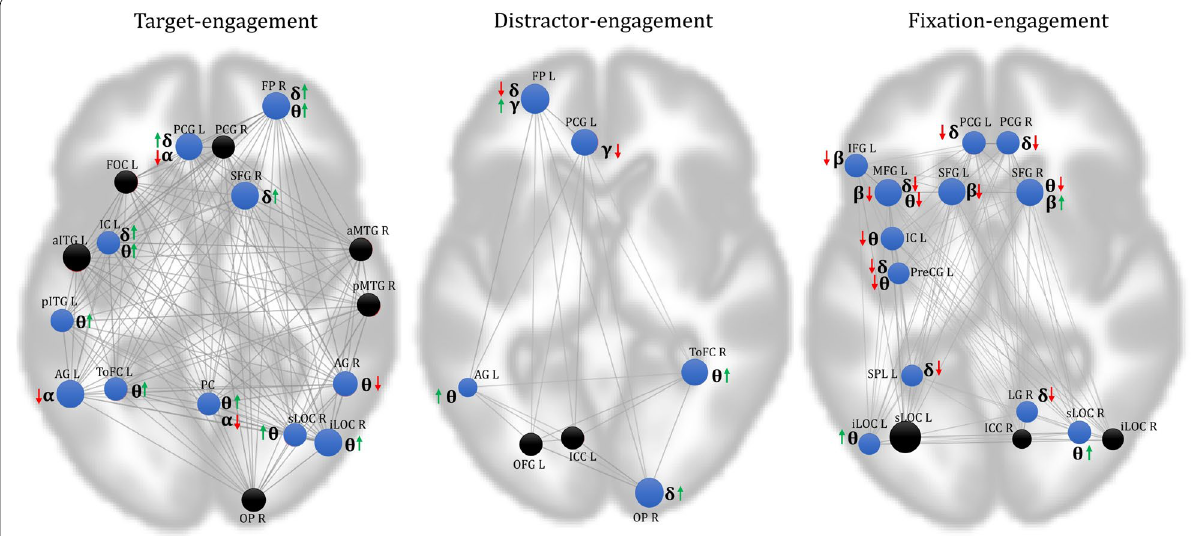
Fig. 7 Neuro-vascular coupling of each significant, fMRI functional connectivity optimized frequency-microstates of every task. The Regions shown are neural correlates observed for every task. The neuro-vascular association of optimized frequency microstate with each region is drawn through the arrow next to it (Synchronization: Up green arrow, De-synchronization: Down Red arrow). The area colored black has no neurovascular association with any of the optimized frequency